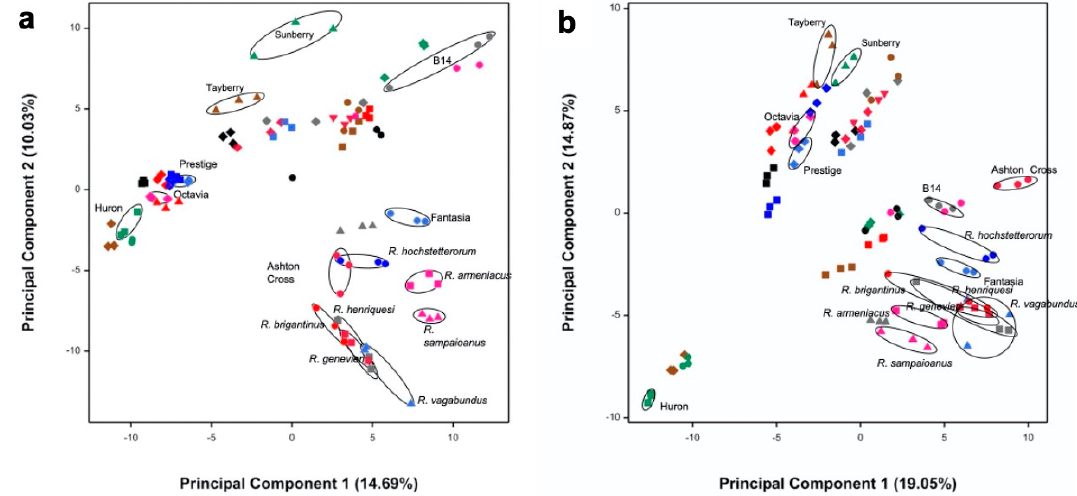
Figure 1. Principal component analysis (PCA) plots of the first two principal components (PCs) for the untargeted analysis acquired in positive ( a ) and negative ( b ) modes. These plots illustrate the phytochemical diversity present within the Rubus germplasm collection analyzed which included 36 species / cultivars. In positive mode, it was possible to identify three major groups comprising black and red raspberries (negative values for principal component 1, PC1), hybrid berries (high positive values for principal component 2, PC2), and wild and some domesticated blackberries (positive for PC1 and negative for PC2). In negative mode, three main groups were also observed, although they comprised black raspberries (negative for PC1 and PC2), red raspberries and hybrid species (high positive values for PC2), and wild and domesticated blackberries clustering with some hybrid species (positive values for PC1). The species selected for evaluation of bioactivity are circled in both plots.